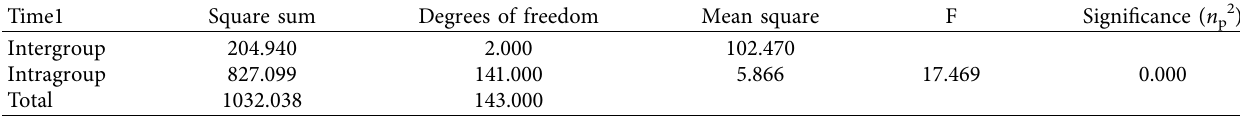
Table 1: Analysis of completion time in brightness variable experiment.